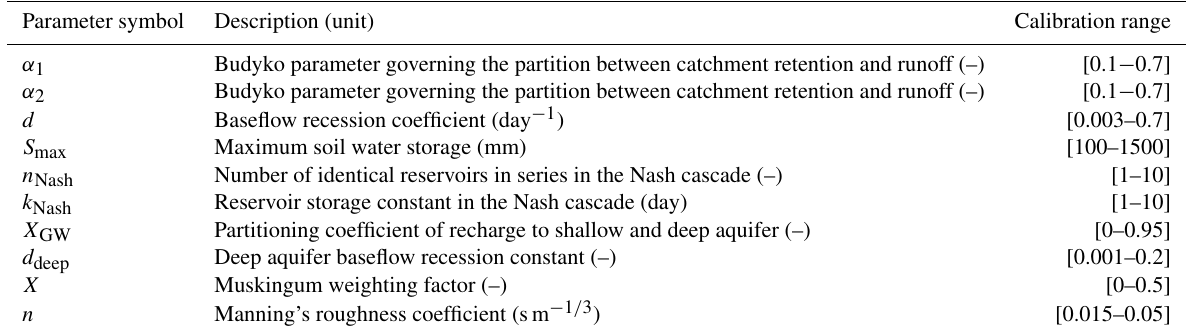
Table 2. Calibrated model parameters – one set of 10 parameters is defined for each calibration region. Calibration ranges are based on early trials, manual calibration and parameter